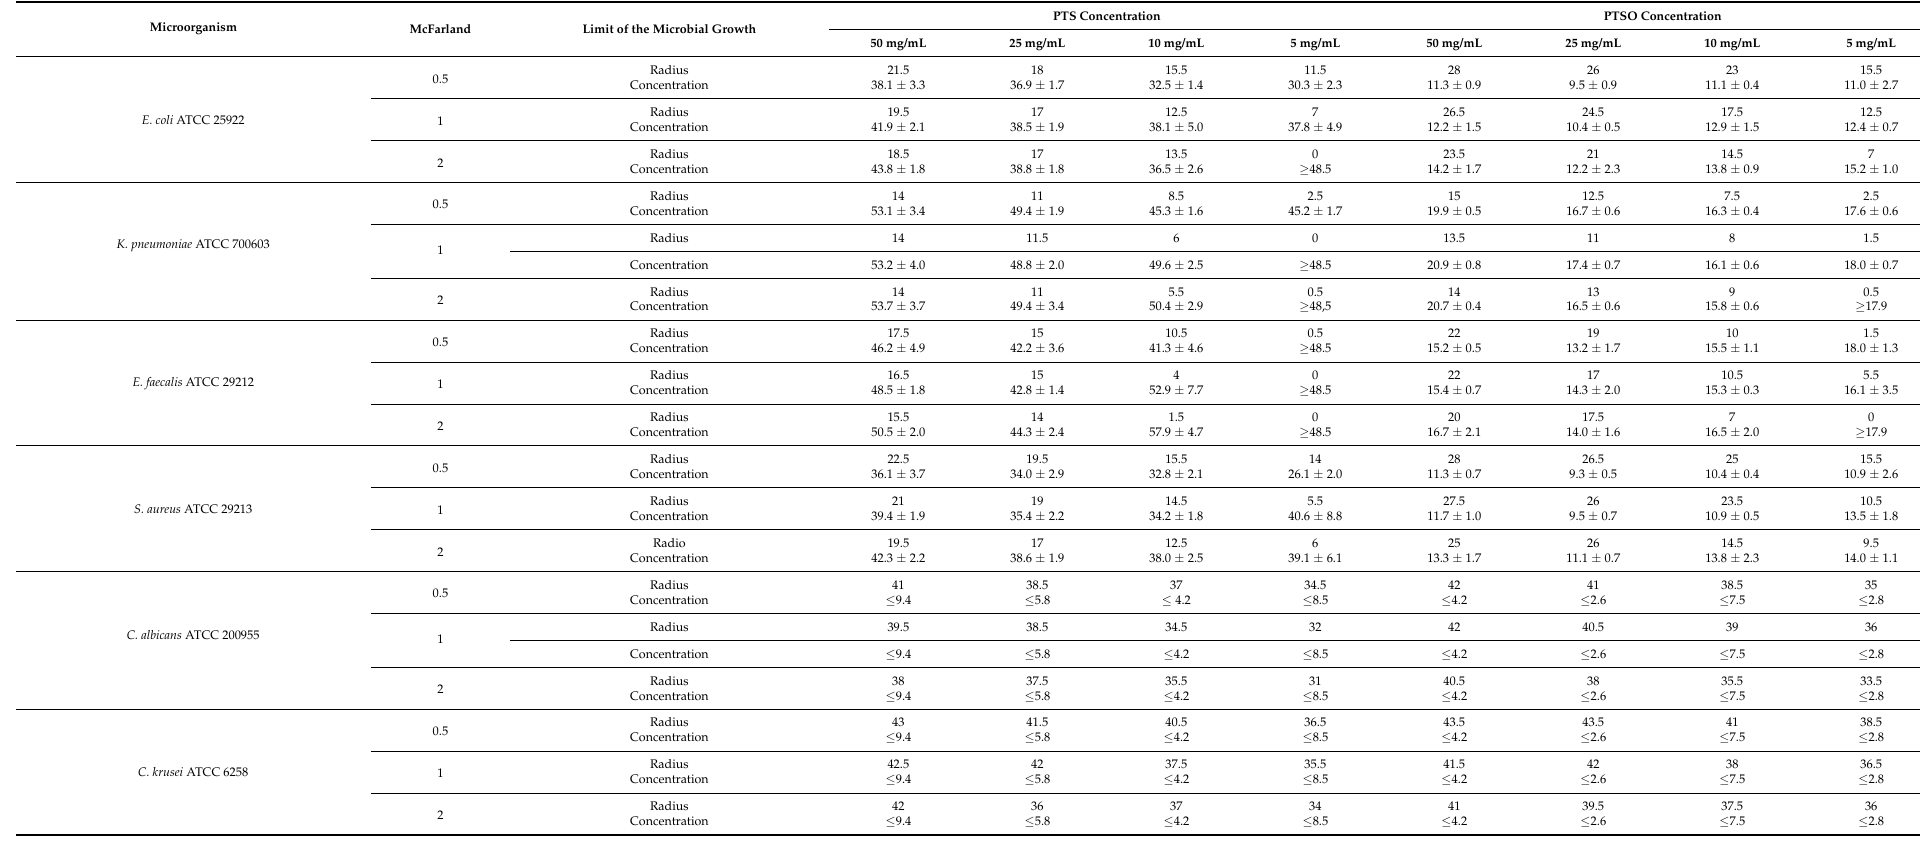
Table 4. Average value ± standard deviation (in mg/L) of the concentration of PTS and PTSO reached at the limit of the microbial growth inhibition zone.